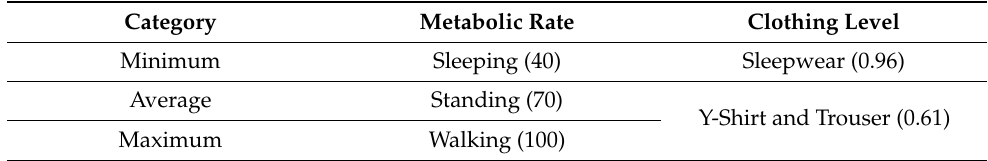
Table 3. Analysis settings of MET rates and CLO levels.